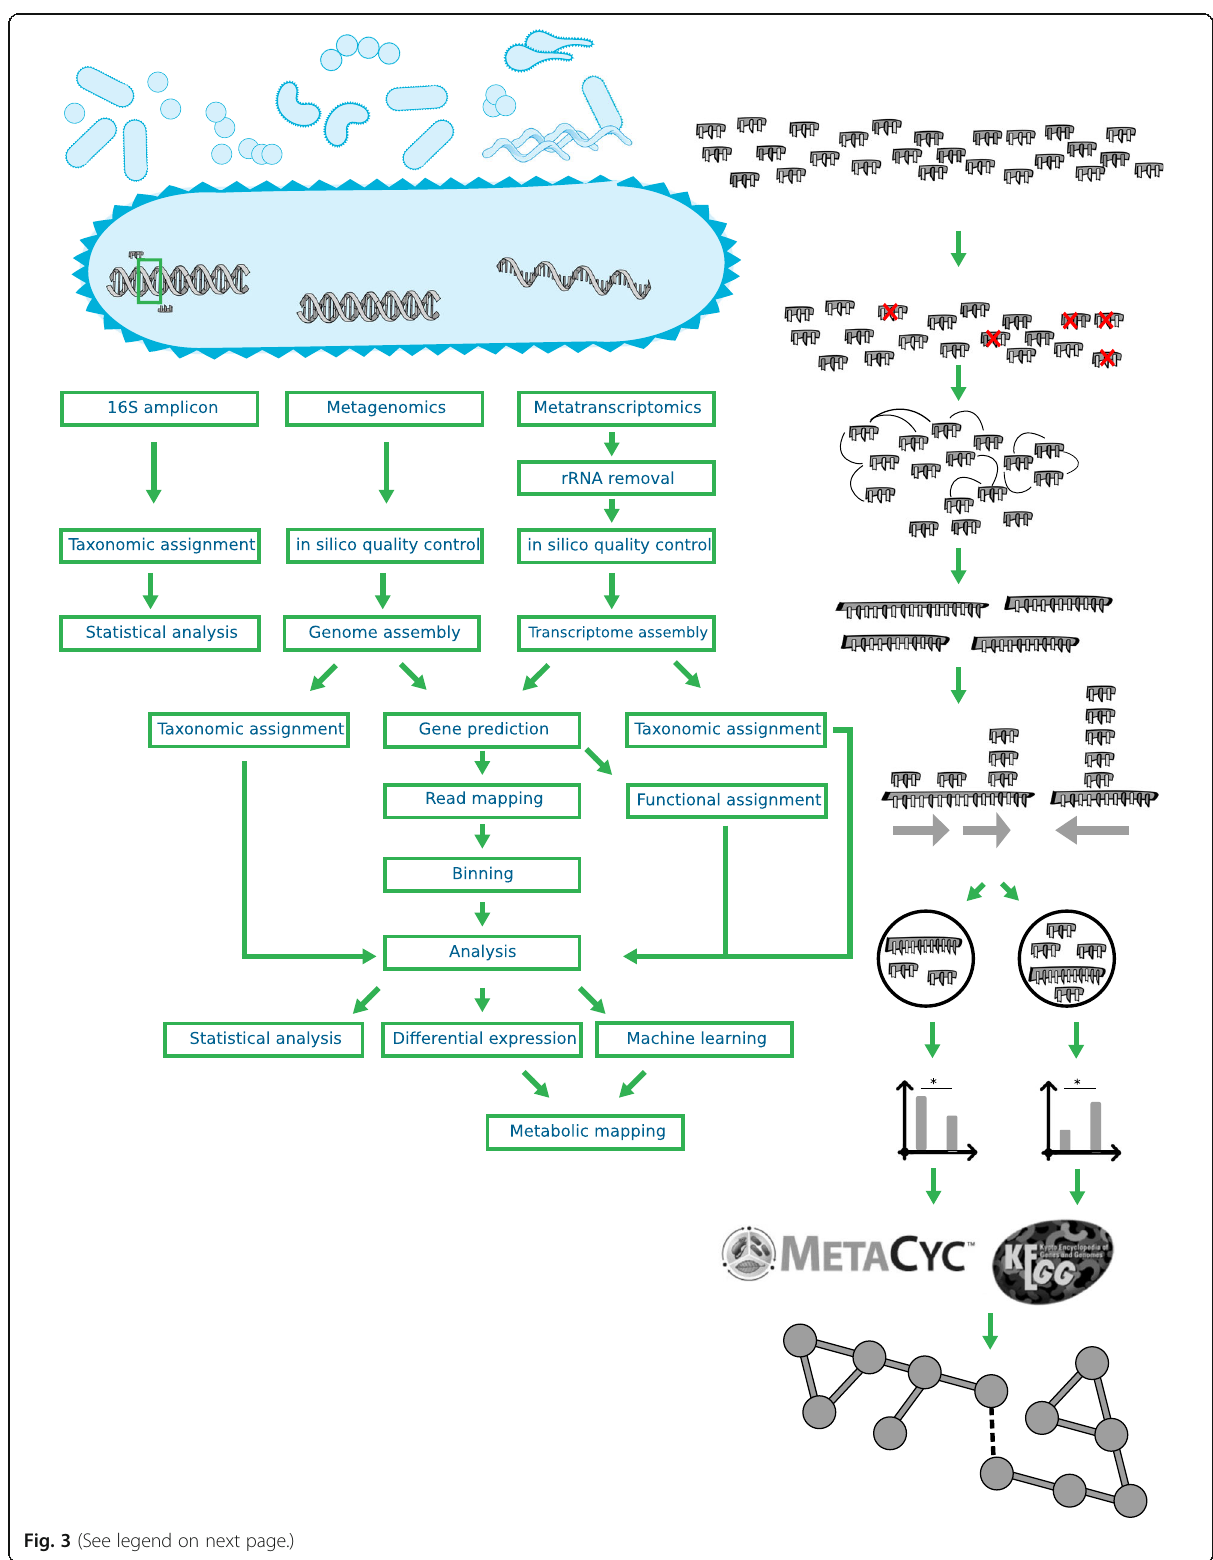
Fig. 3 (See legend on next